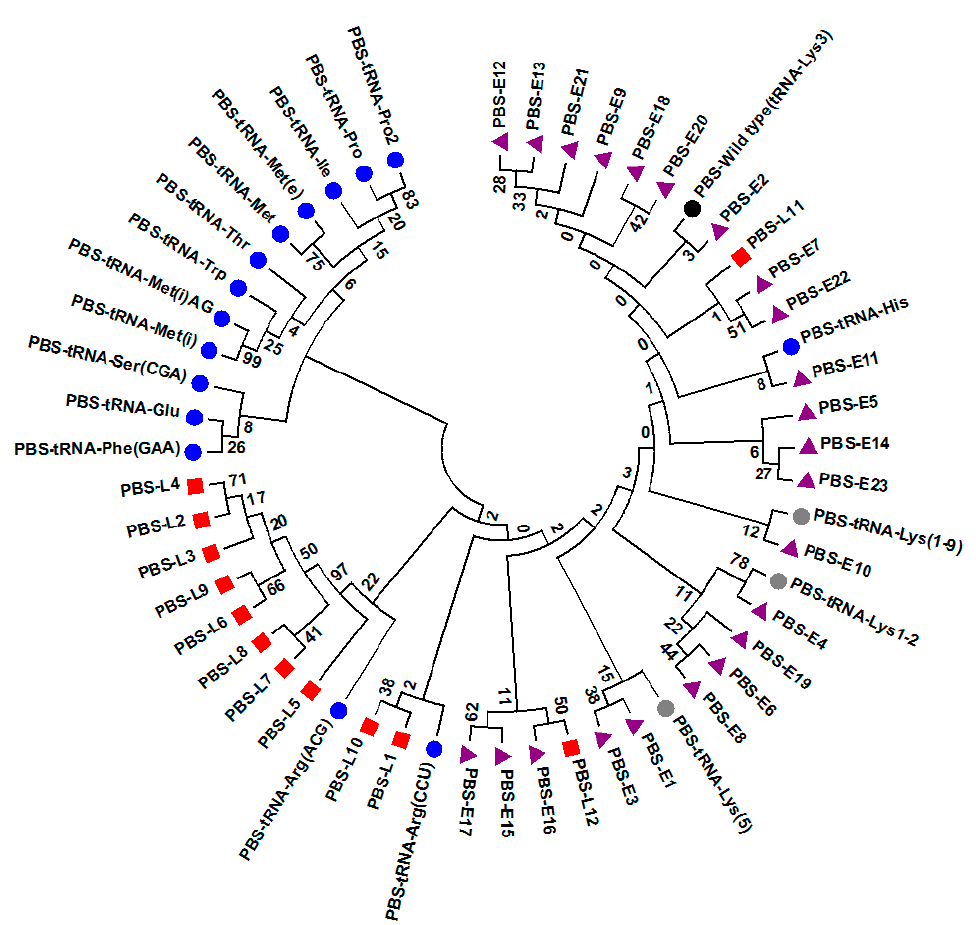
Figure 11. Molecular phylogenetic analysis of PBS sequence variants identified only in late (PBS-1 as PBS-L) or early (PBS-4 as PBS-E) seroconverters by maximum likelihood method with reference